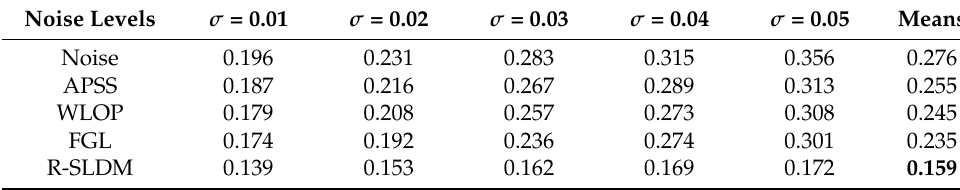
Table 2. MSE of five different denoising algorithms for Daratech models.